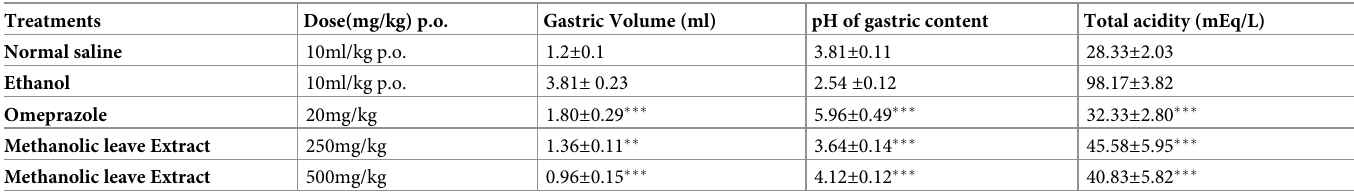
Table 7. Effect of different methanolic extracts of E . spinosa on gastric ulcer, gastric volume, pH, total acidity in acute ethanol-induced gastric ulcer. Treatments Dose(mg/kg) p.o. Gastric Volume (ml) pH of gastric content Total acidity (mEq/L) Normal saline 10ml/kg p.o. Ethanol 10ml/kg